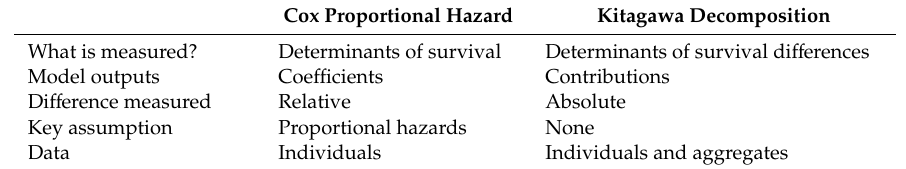
Table 5. Summary of the Cox proportional hazard and Kitagawa decomposition models characteristics.